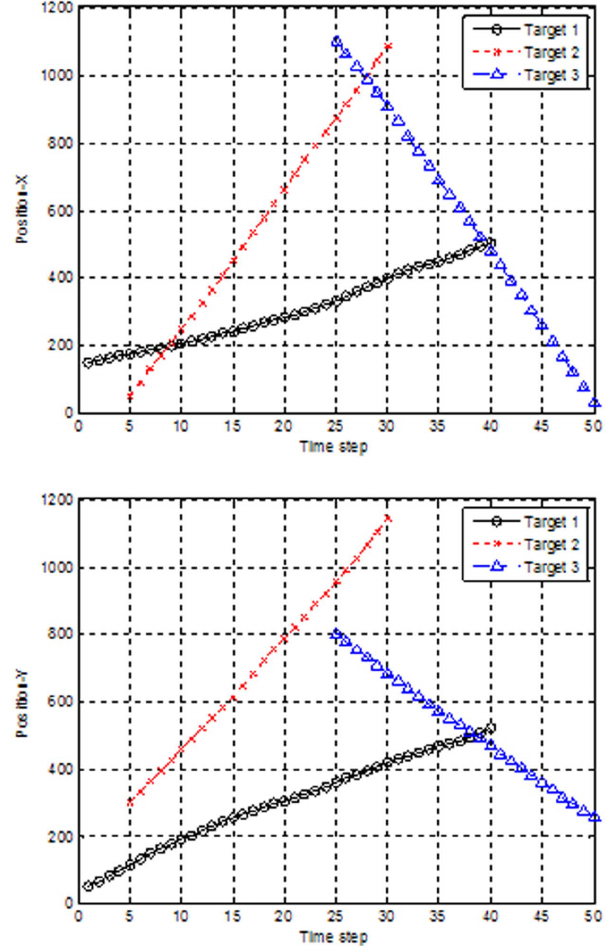
Figure 1. Target